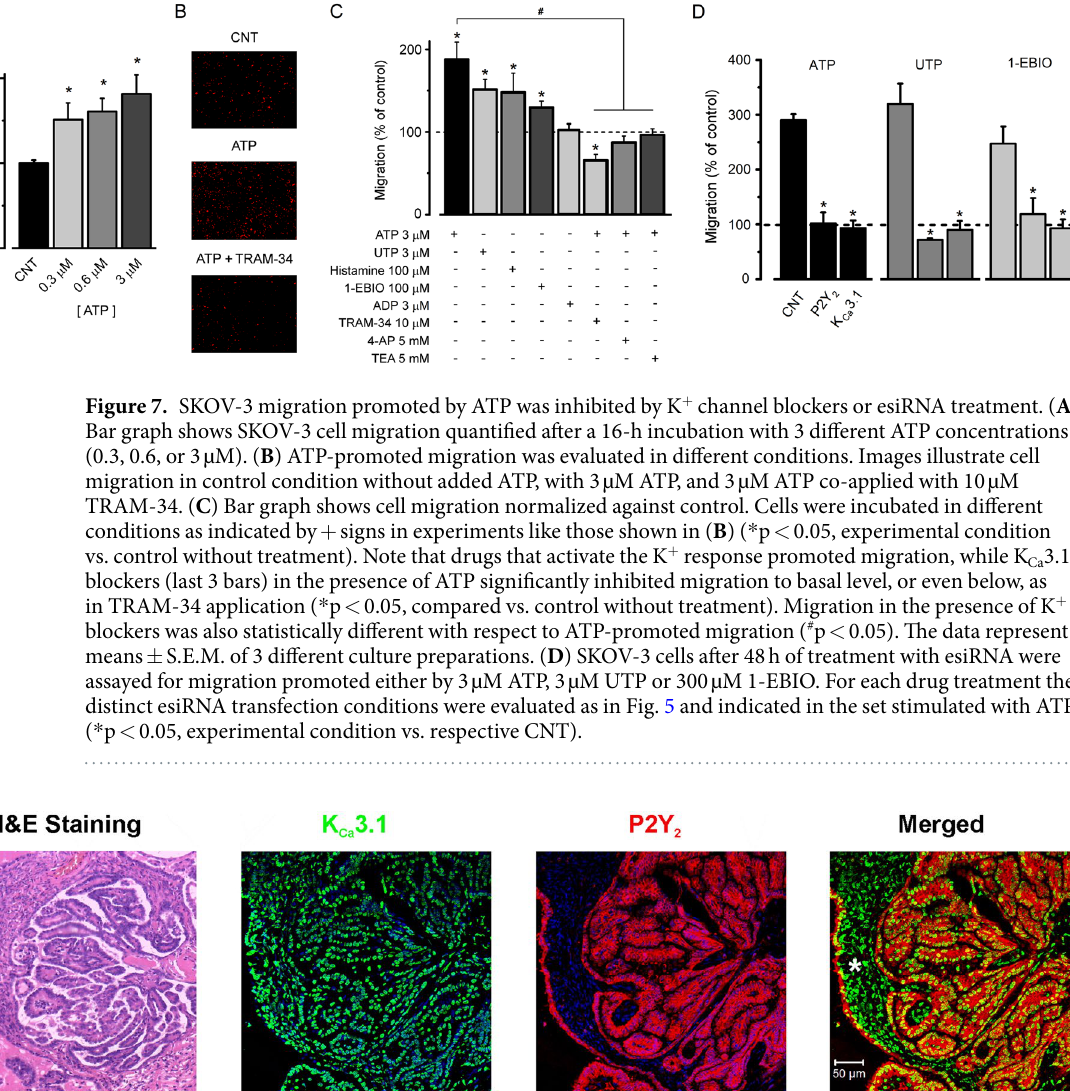
morphology. The electrical response was generated, most probably, as a consequence of the [Ca 2 + ] i increase gen- erated by its release from internal stores, through the activation of specific receptors coupled to G proteins 16 . This idea is supported first, because a [Ca 2 + ] i increase was readily observed when the cells were stimulated by ATP or histamine at µ M concentrations, as reported in previous studies, and also because the main electrical response corresponded to the generation of a Ca 2 + -dependent ionic current. The SKOV-3 response elicited by ATP and histamine had multiple phases; however, an outward current component was the most consistent and prominent. This response was mimicked by applying several purinergic agonists that, together, indicated participation of P2Y receptors sensitive to UTP. Nevertheless, comparatively small and fast inward responses elicited by ATP, but not by UTP (or ADP), seemed to indicate involvement of P2X channels in this particular response. The main UTP-sensitive P2Y receptors are the P2Y 2 , P2Y 4 and P2Y 6 subtypes, and expression analysis by PCR and immunocytochemistry showed that P2Y 2 and P2Y 4 were the main receptors expressed in SKOV-3 cells. However, given that the human P2Y 4 receptor is not activated by ATP 22 , the potency sequence for the distinct agonists